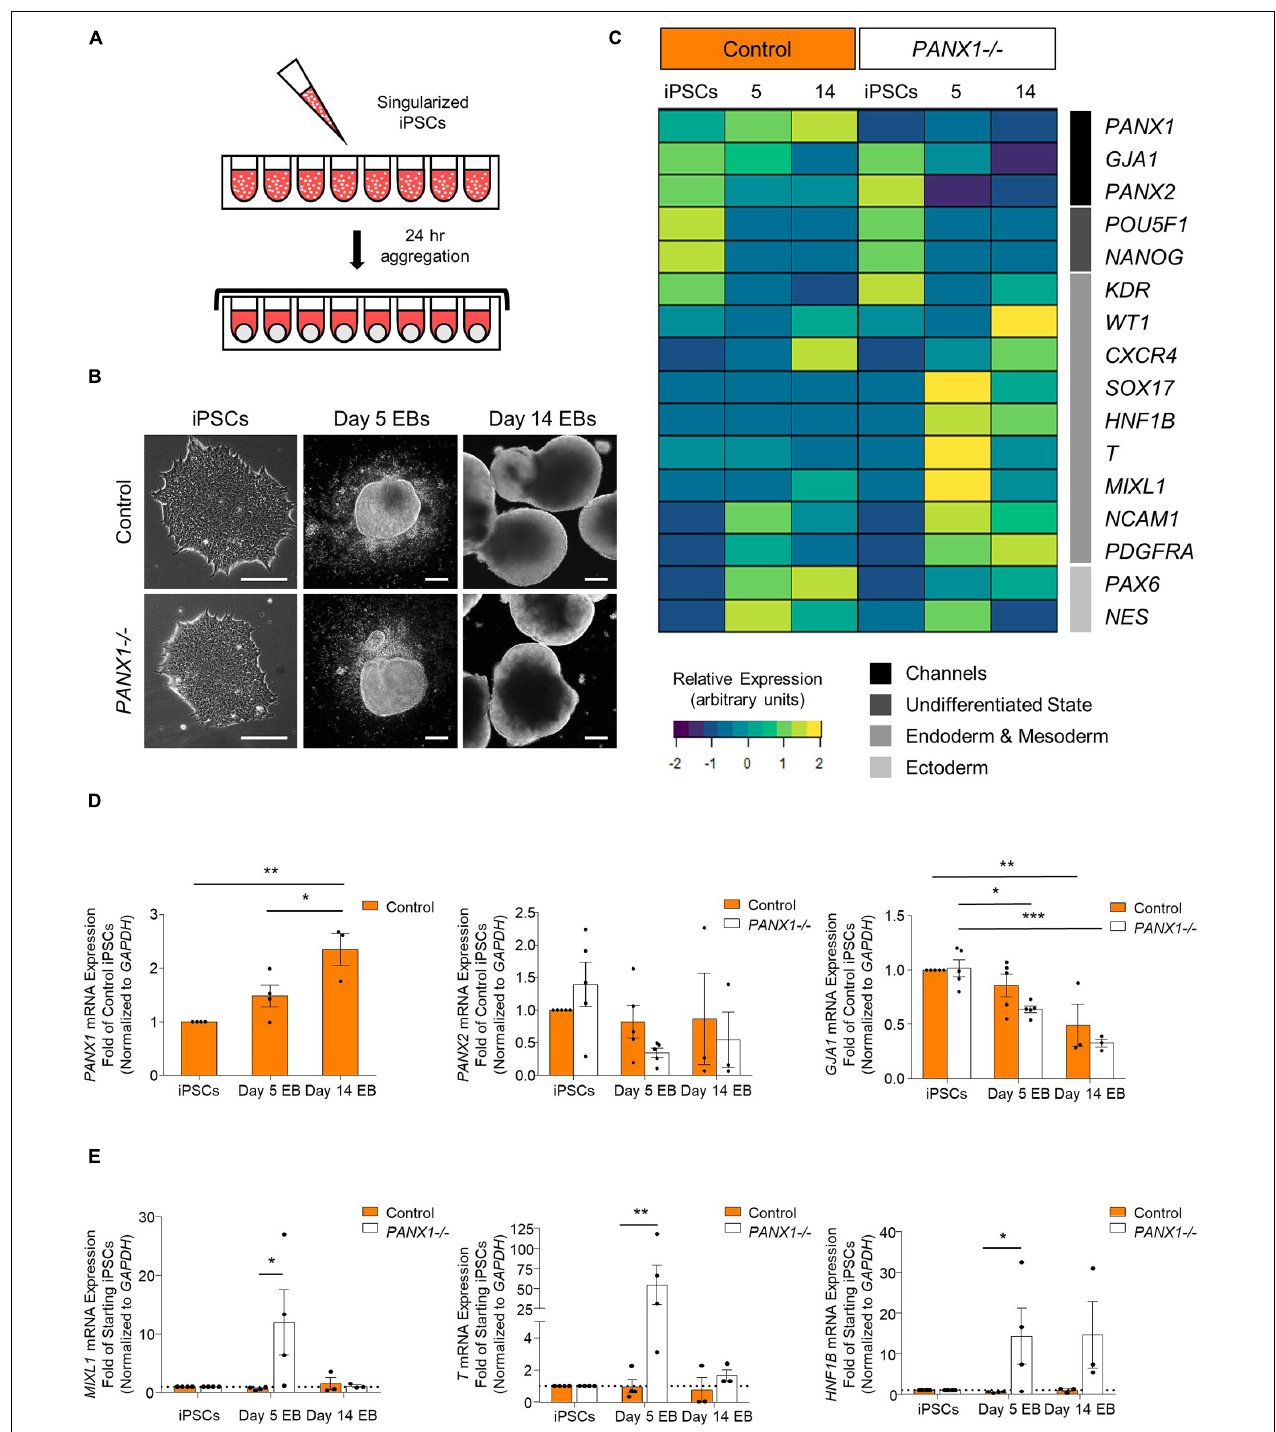
FIGURE 5 | PANX1 knockout embryoid bodies exhibit skewed lineage specification. (A) Schematic depicting 3D embryoid body (EB) formation. (B) Control and PANX1-/- iPSCs self-aggregate and form embryoid bodies. Scale bar = 200 um. (C) Gene expression analysis of control and PANX1-/- iPSCs as well as embryoid bodies after 5 and 14 days of spontaneous differentiation. The heatmap was generated using the average 2 − (cid:49) CT data value (normalized to GAPDH ) for each condition using R Studio software with the ggplots. 2 package and row clustering. Transcripts for PANX3 were not detected at any point during differentiation. (D) PANX1 , PANX2 and GJA1 (Cx43) qPCR gene expression analysis of control and PANX1-/- iPSCs and embryoid bodies after 5 and 14 days of spontaneous differentiation. (E) Lineage-specific gene expression of control and PANX1-/- iPSCs and embryoid bodies after 5 and 14 days of spontaneous differentiation. Bar graph data presented as 2 − (cid:49)(cid:49) CT (fold change of iPSCs). Data represents the mean of 3-5 independent experiments. ∗ , p < 0.05; ∗∗ , p < 0.001; ∗∗∗ , p < 0.0001 compared to starting